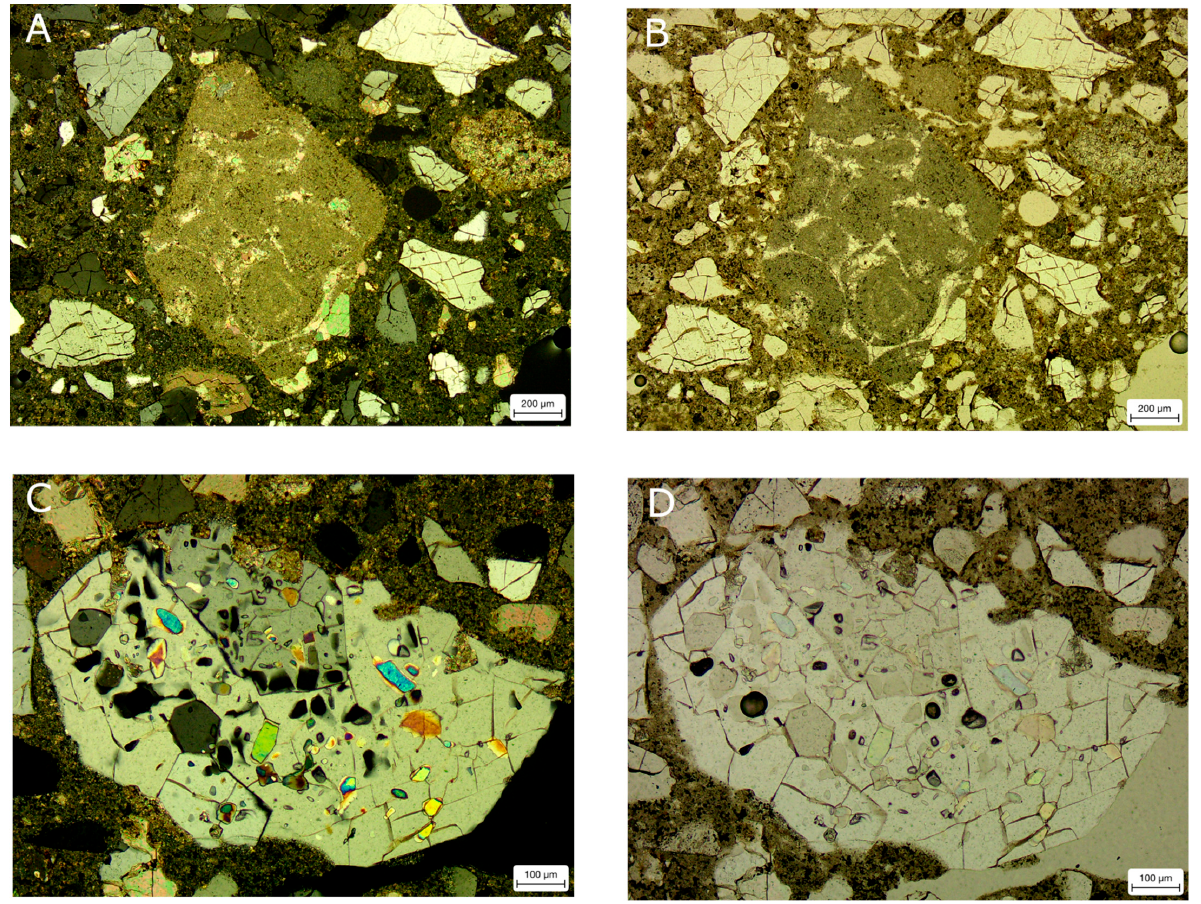
Figure 9. ( A , D ) Showing calcareous rock fragments in ( A , B ) (central view), and fractured quartz grains as the main aggregate in ( C , D